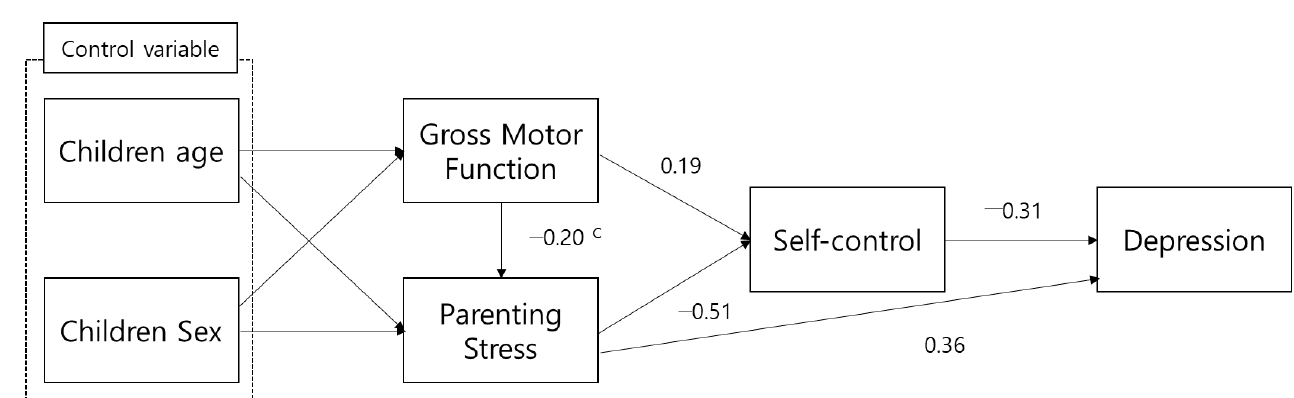
Figure 1. Proposed path model. c = standardized coefficient.